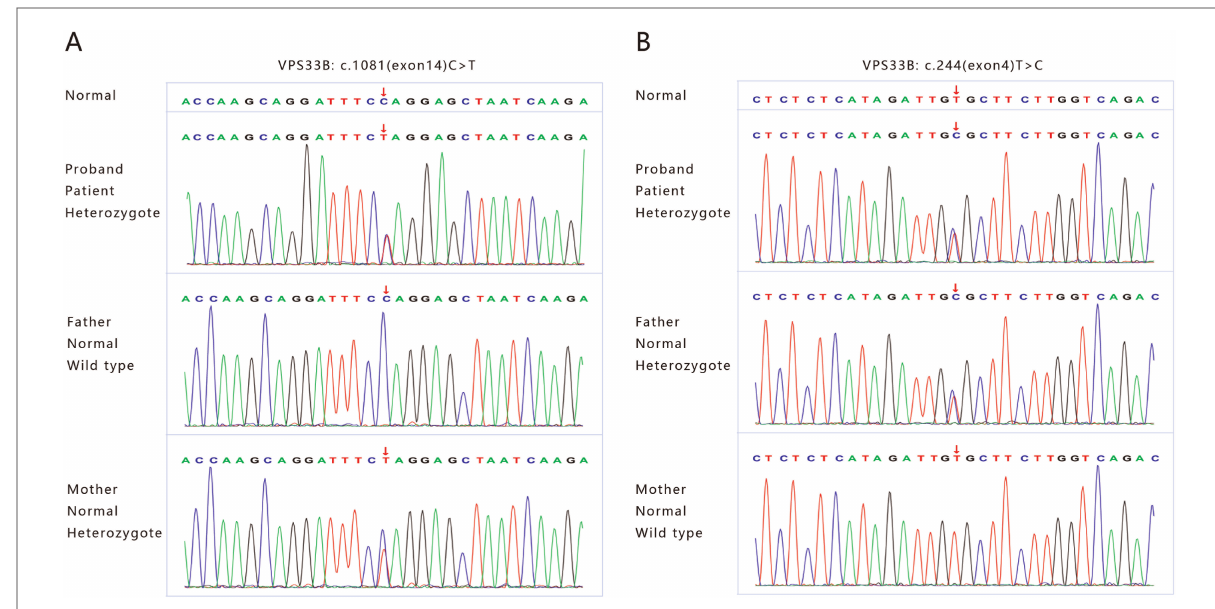
FIGURE 2 The whole exon gene sequencing showing two novel heterozygous mutations in VPSS33B gene. ( A ) The fi rst mutation is c1081(exon14)C>T, NM_018668, p .Q361X,257, which originated from the patient ’ s mother. ( B ) The second mutation is c.244(exon4)T>C, NM_018668, p .C82R, which originated from the patient ’ s